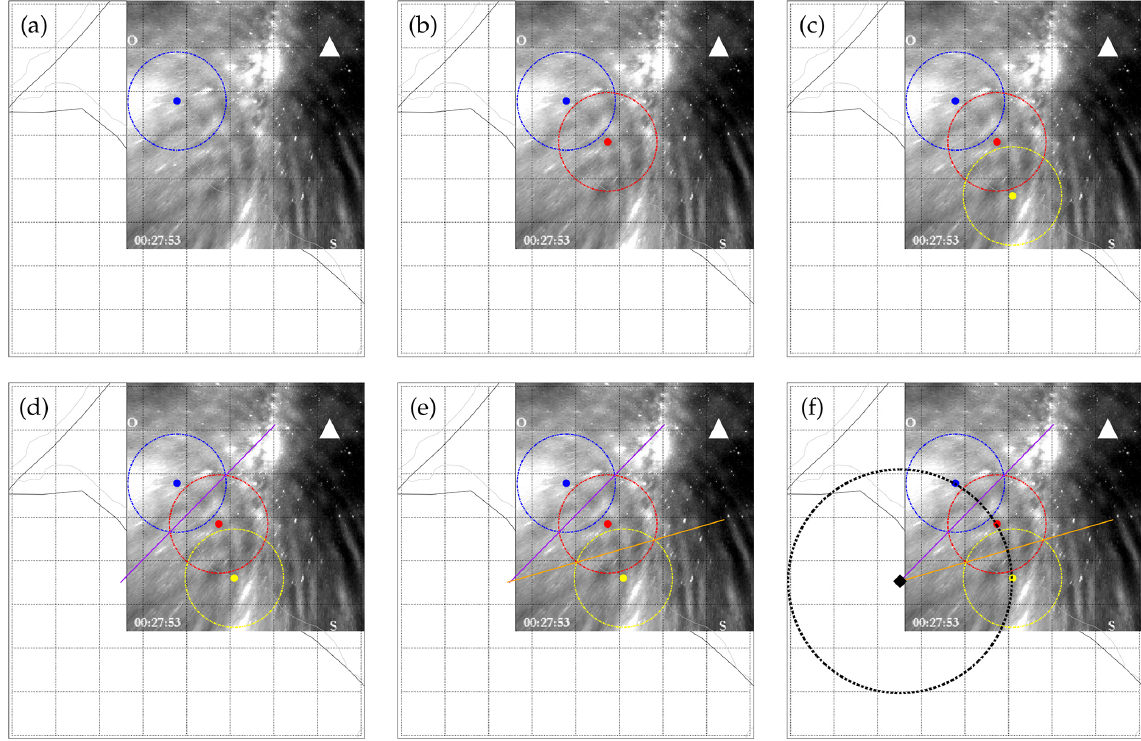
Figure 3. Illustration of each step of the methodology used to determine the center of a CGW.